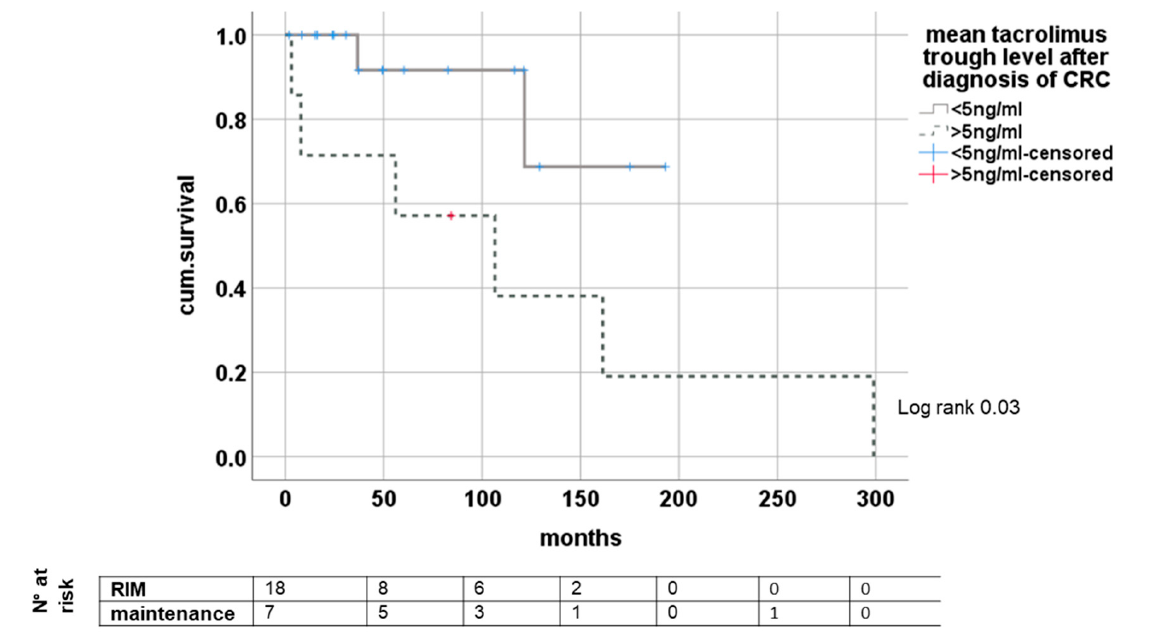
Figure 4. Dependence of survival from tacrolimus trough level after de novo CRC.